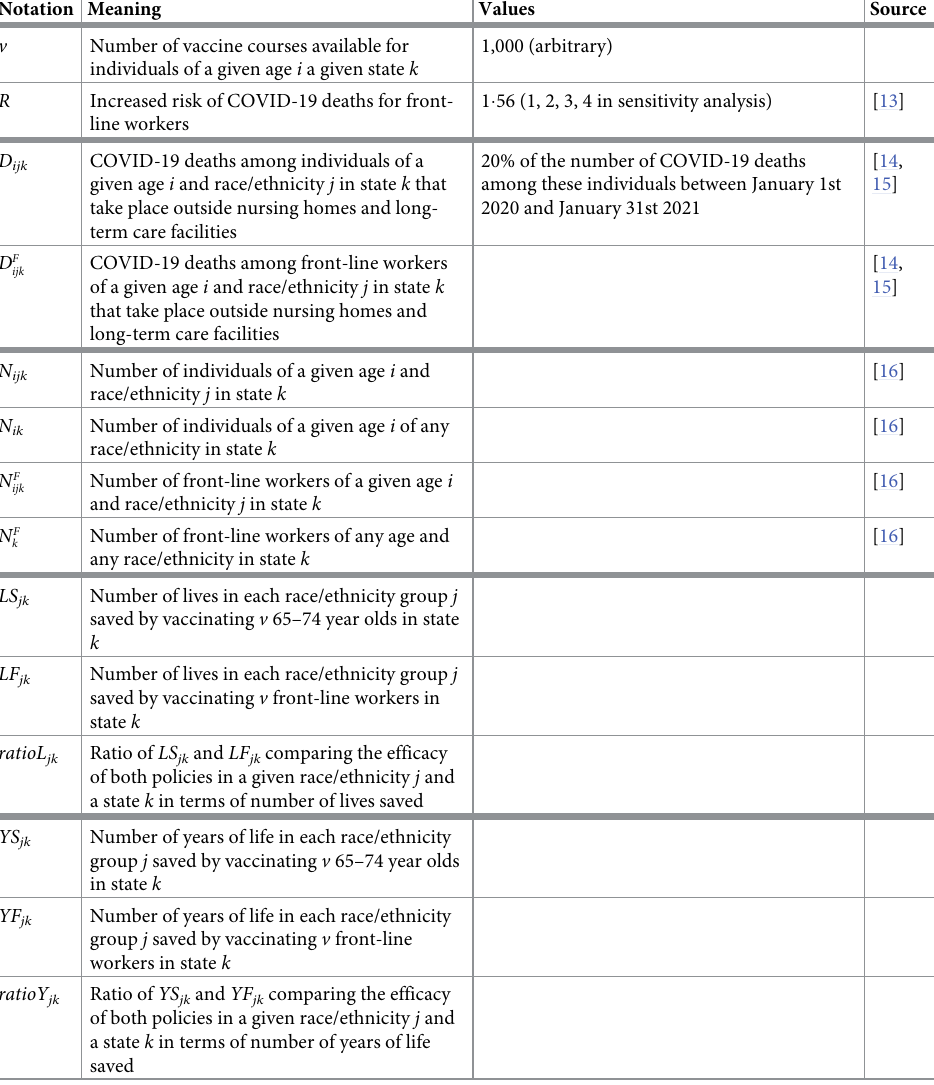
Table 1. Notation and input